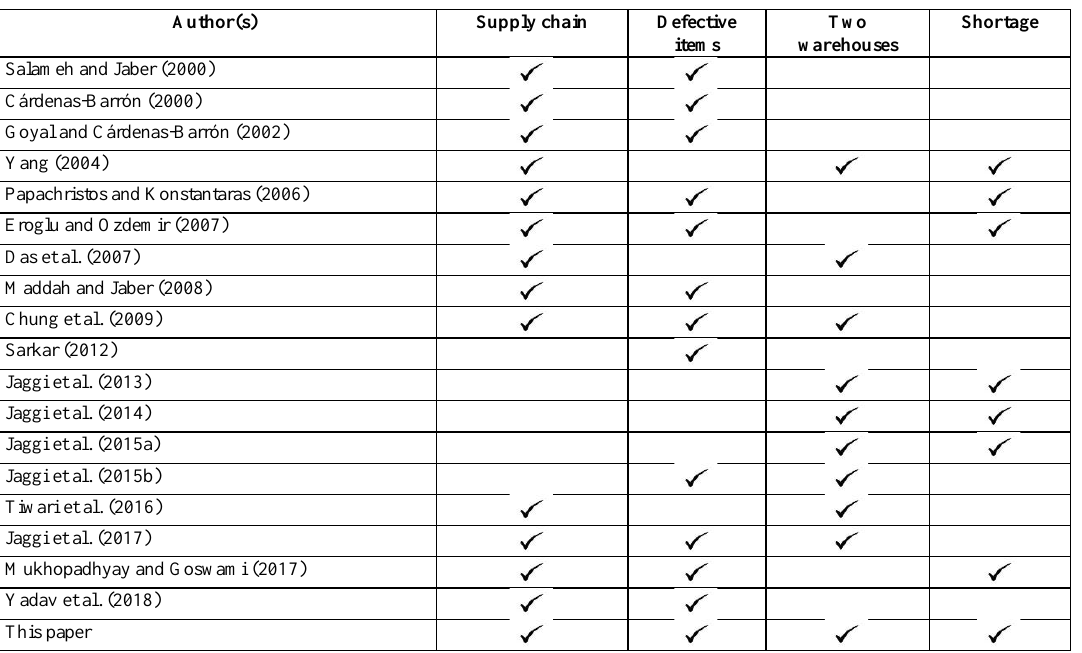
Table 1. Some research works related to inventory